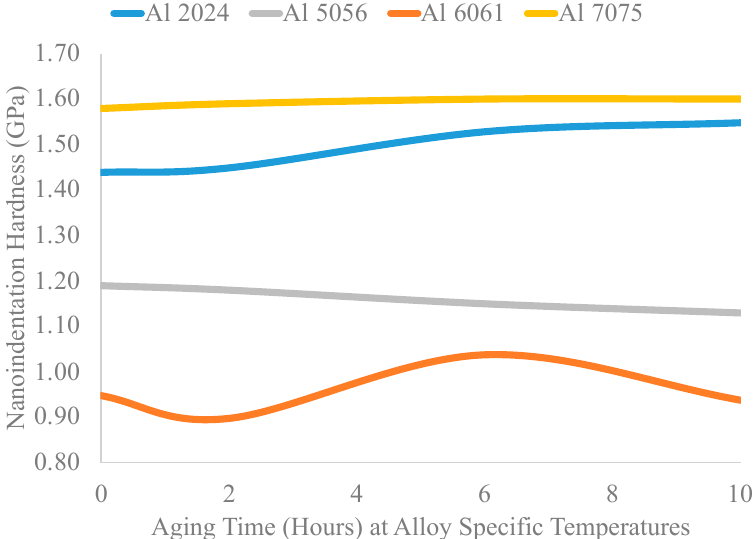
Figure 14. Static nanoindentation aging curves using the Keysight G200 system.